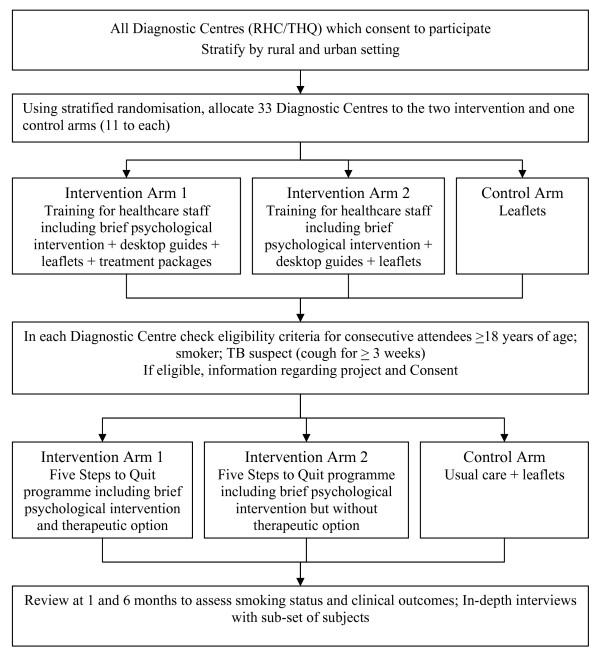
Trial flow chart.